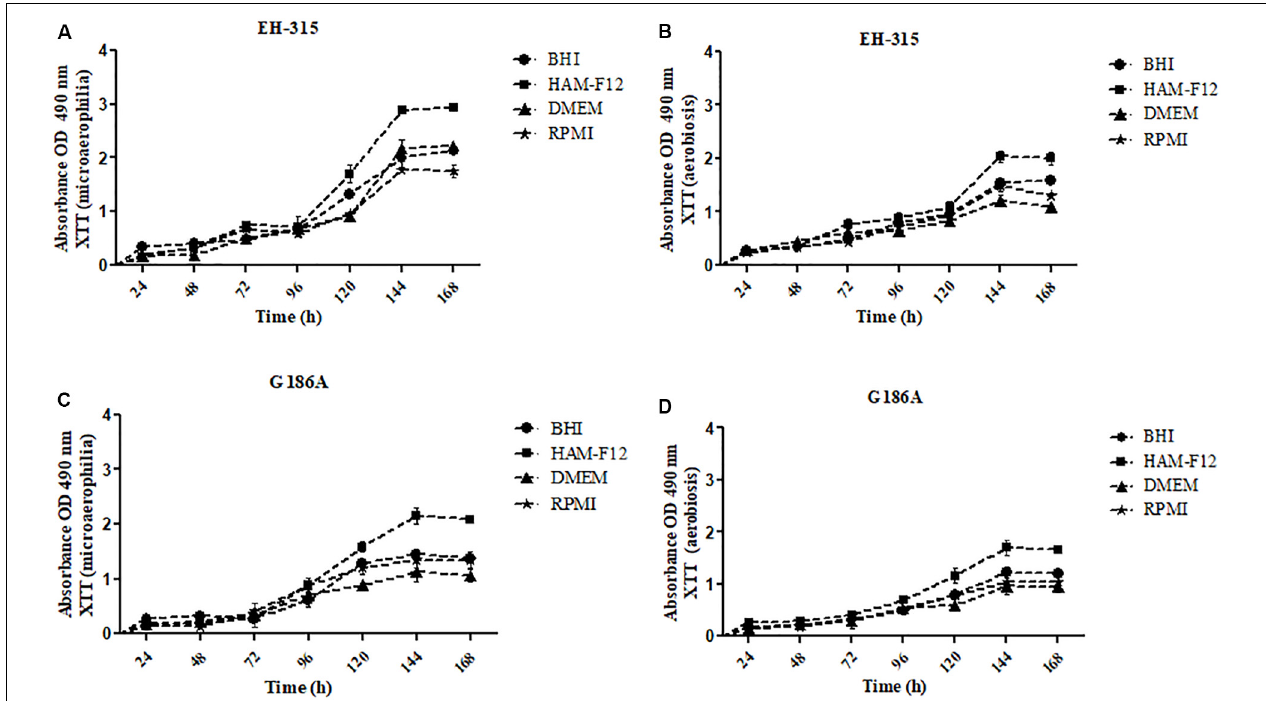
FIGURE 1 | Kinetics of metabolic activities of biofilms formed by different strains of H. capsulatum (A,B) EH-315 and (C,D) G186A in microaerophilia (A–C) and aerobiosis (B–D) conditions.